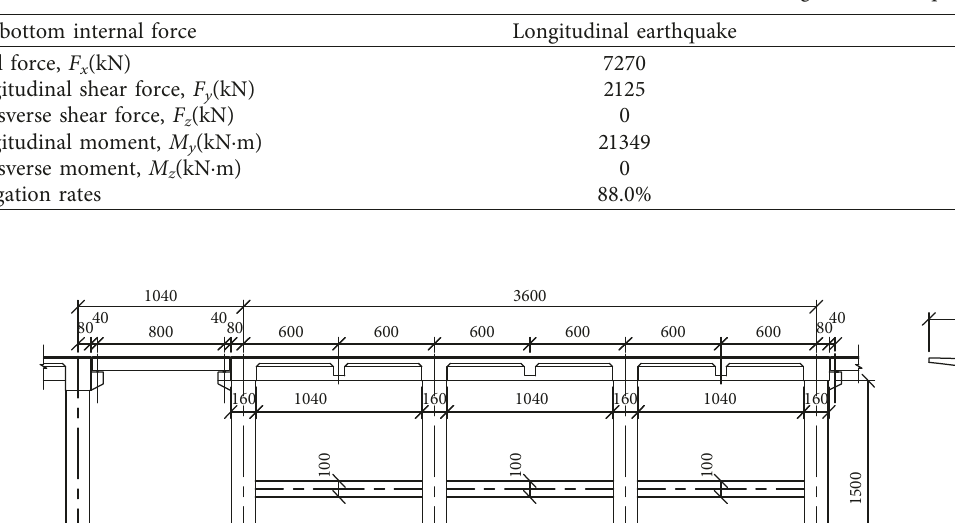
Table 10: Pier bottom internal forces with isolation devices under high-level earthquake.